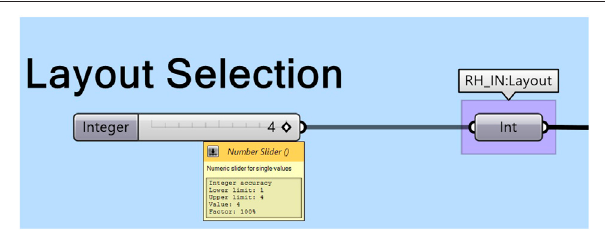
FIGURE 4 | User input is implemented with sliders in the usual Grasshopper work fl ow, and with annotated auxiliary variables in our work fl ow using RhinoCompute.